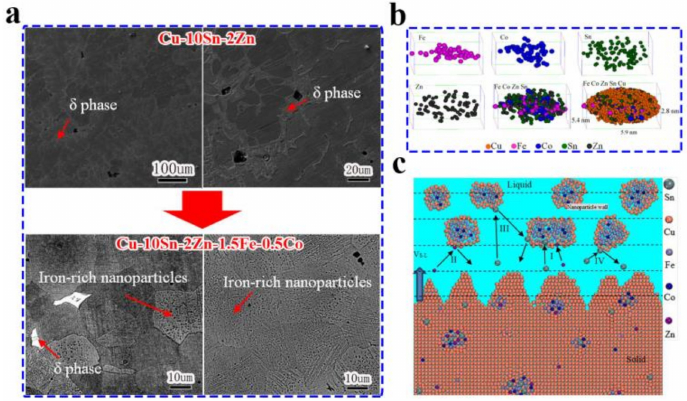
Figure 14. ( a ) SEM micrographs showing microstructure of cast Cu-10Zn-2Sn and Cu-10Sn-2Zn- 1.5Fe-0.5Co alloys, ( b ) a 3D atom map reconstruction of an iron-rich nanoparticle and ( c ) in-situ nanoparticle wall model: densely distributed nanoparticles near solid/liquid interface inhibit Sn atom segregation